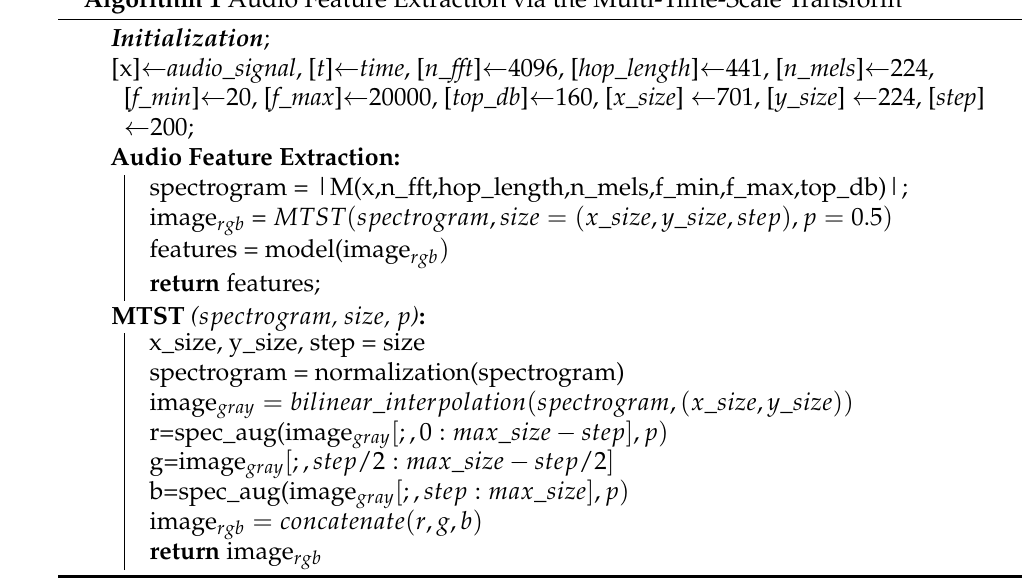
Algorithm 1 Audio Feature Extraction via the Multi-Time-Scale